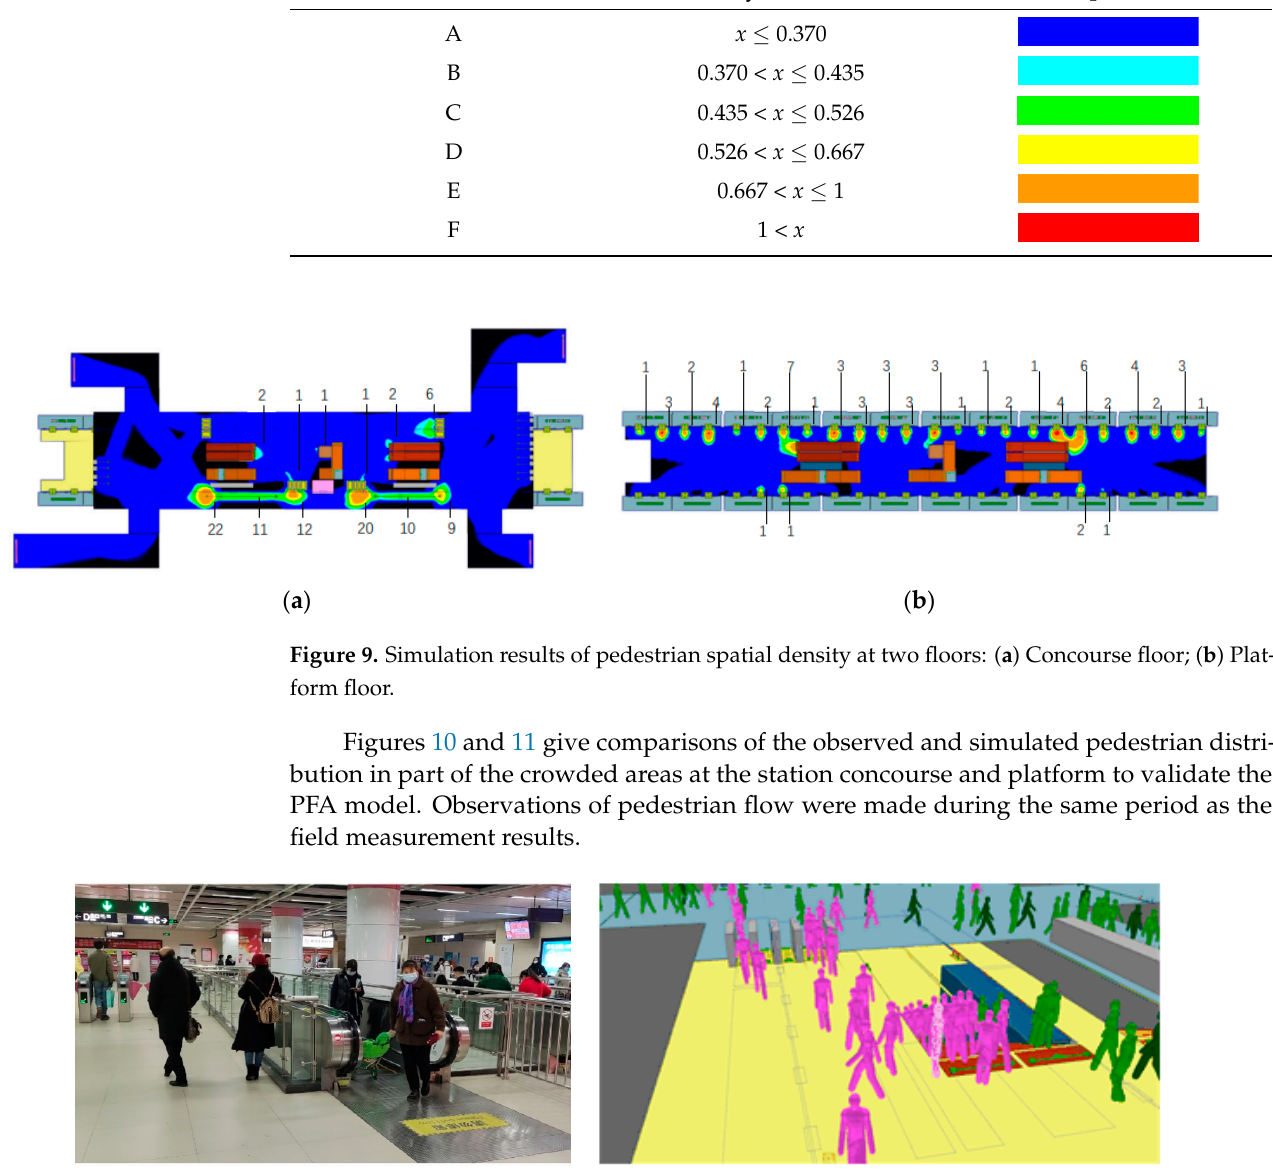
Figure 10. Observed and simulated pedestrian distribution at the stairway of the concourse floor: ( a ) Observed result; ( b ) Simulation result.